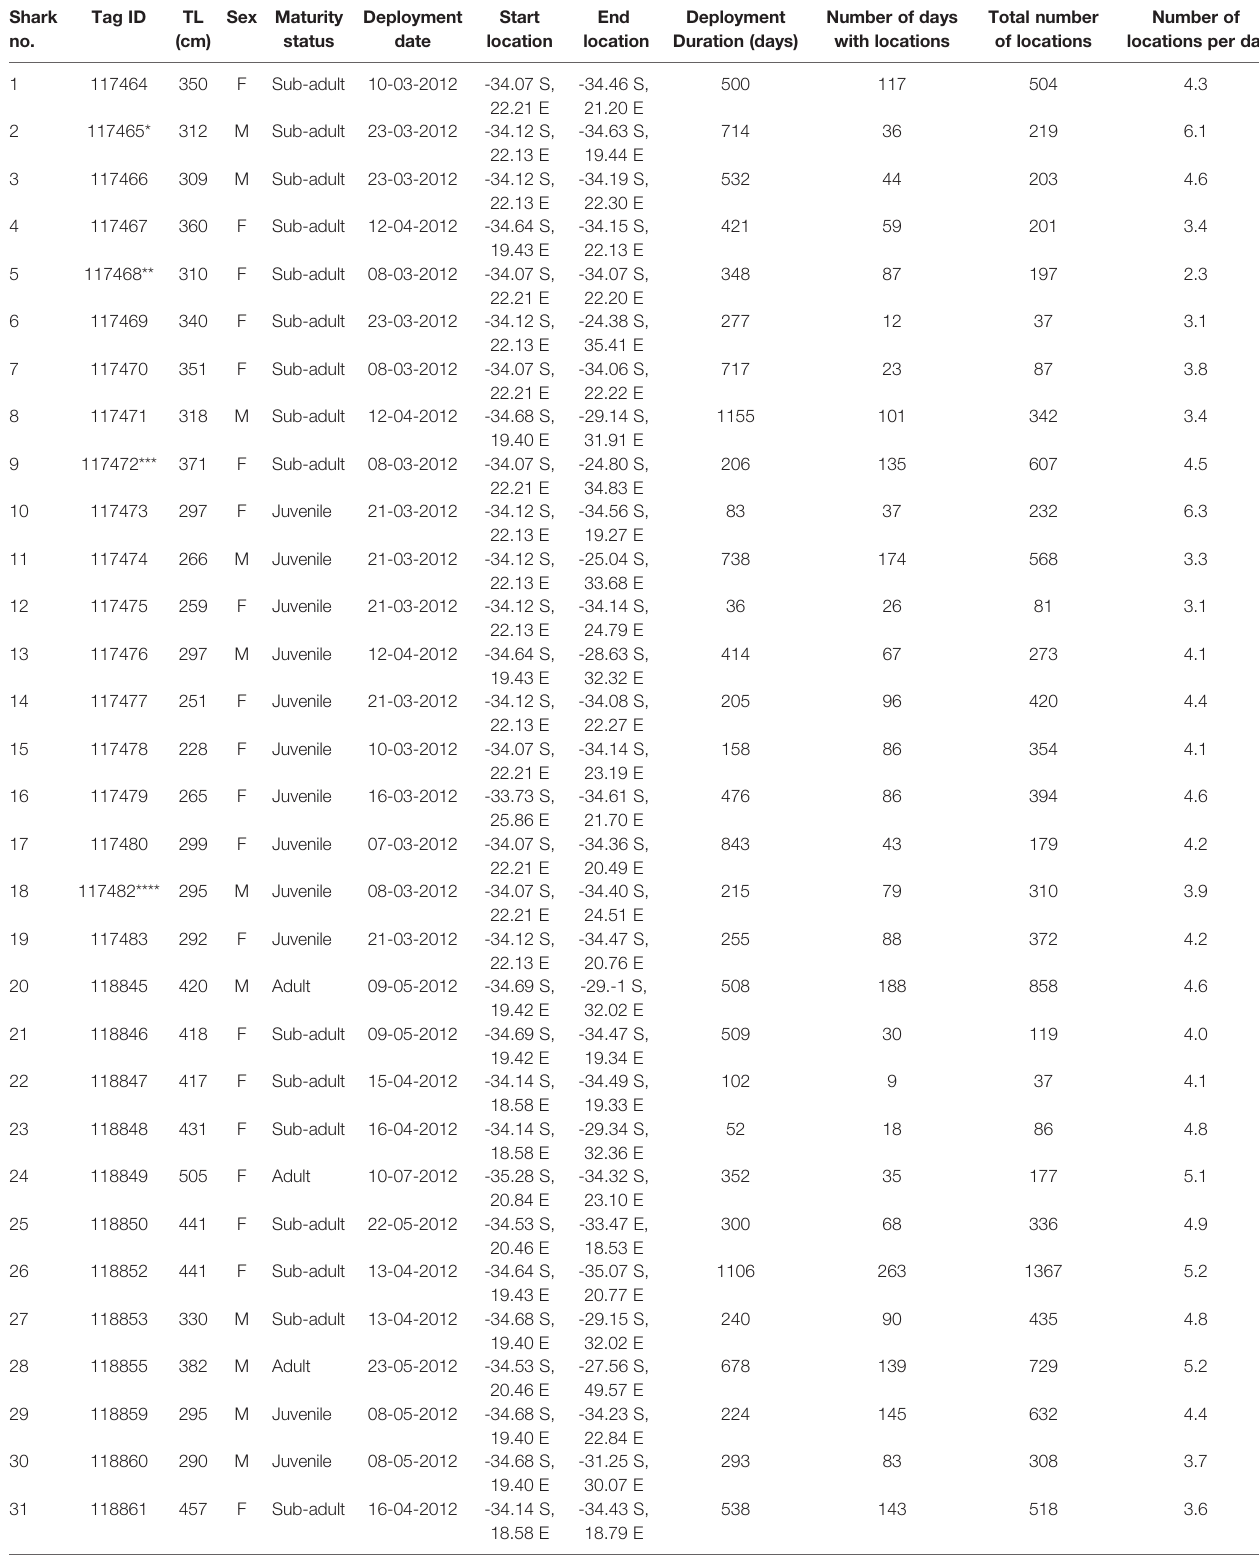
TABLE 1 | SPOT5 transmitter (Wildlife Computers) summary information for white sharks Carcharodon carcharias tagged in South Africa in 2012. Shark